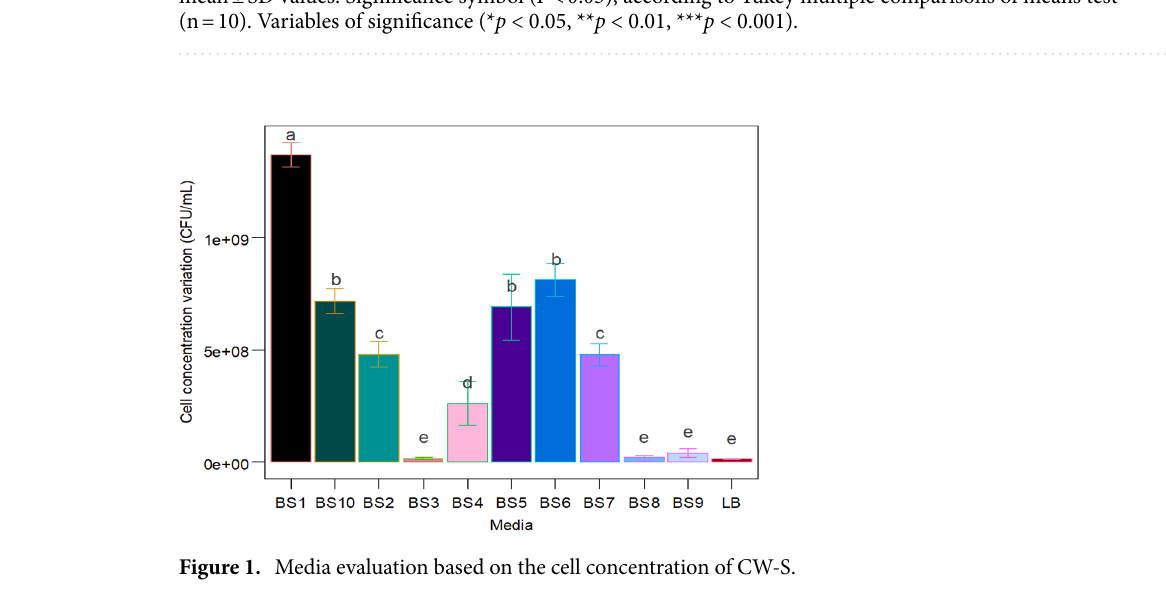
Table 1. The effects of the CW-S strain on wheat seedlings in compared to control. *Within column, mean ± SD values. Significance symbol ( P < 0.05), according to Tukey multiple comparisons of means test